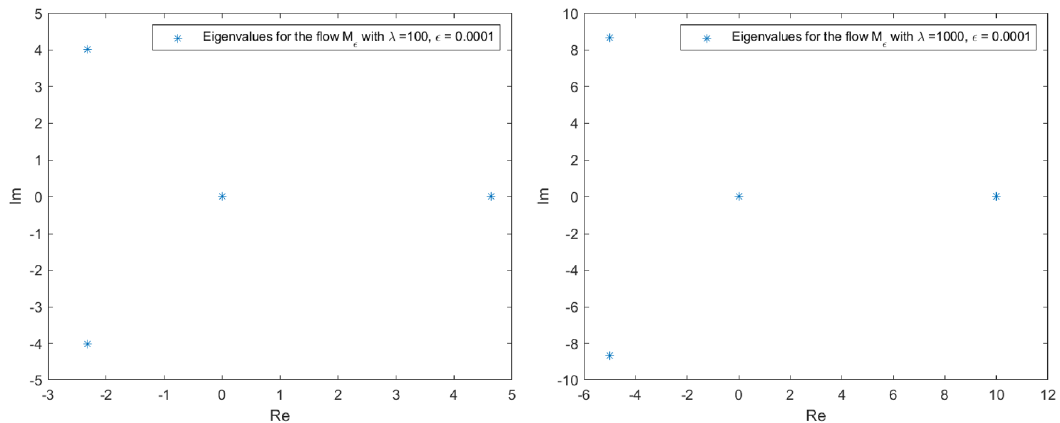
Figure 6. M ǫ eigvenalues evolution for (cid:31) = 100 (left) and (cid:31) = 1000 (right). Note that c = 1 and q = 2 . A solution in B r ( 0 ) can be obtained by linear combination of the exponential bundles associated to each